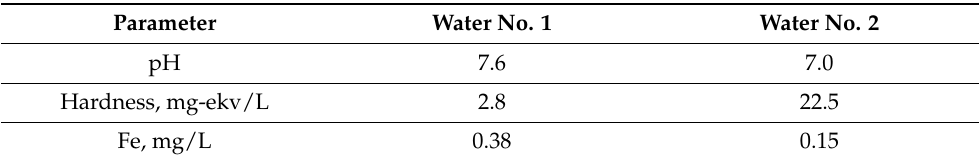
Table 16. Water characteristics.